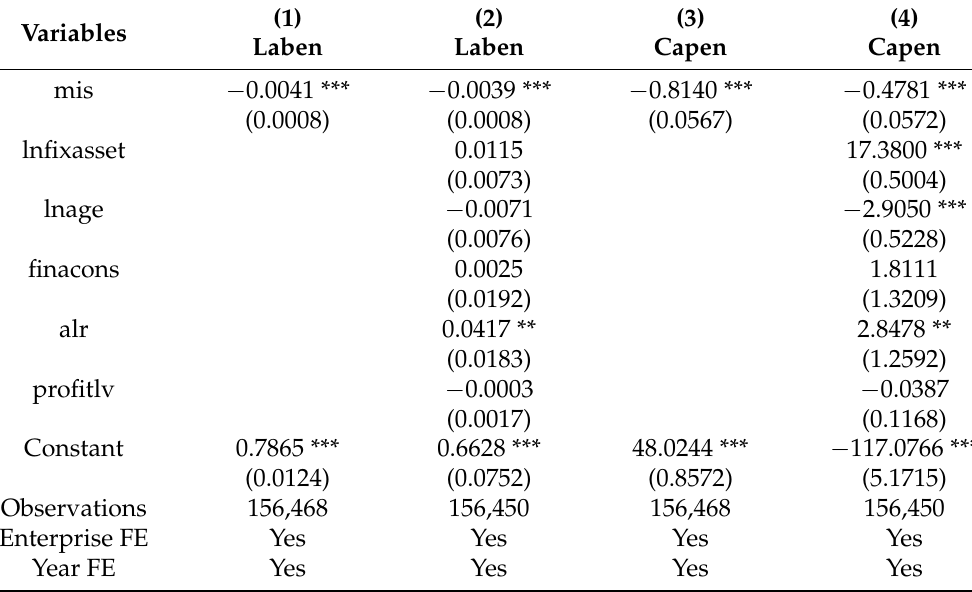
Table 5. Empirical results of Hypothesis